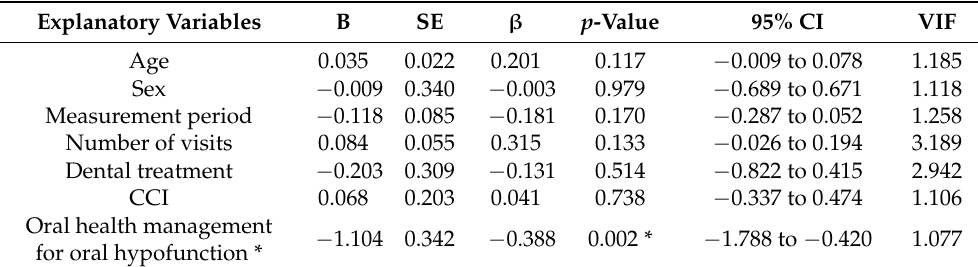
Table 6. Multiple regression analysis of the amount of improvement in the number of hypofunctional items for oral hypofunction between the 1st and 2nd